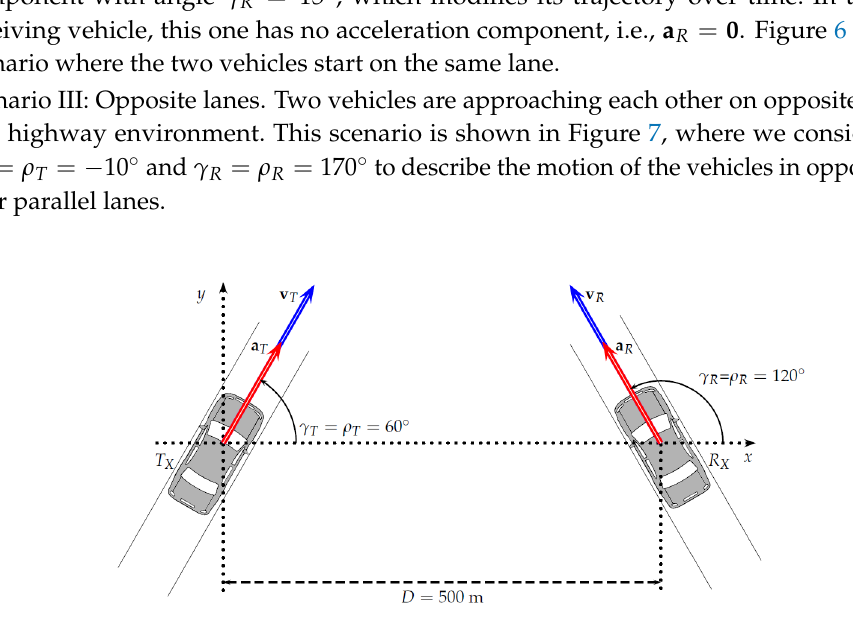
Figure 5. Scenario I: Propagation scenario reproducing a safety situation, where two vehicles are approaching an intersection on the road.